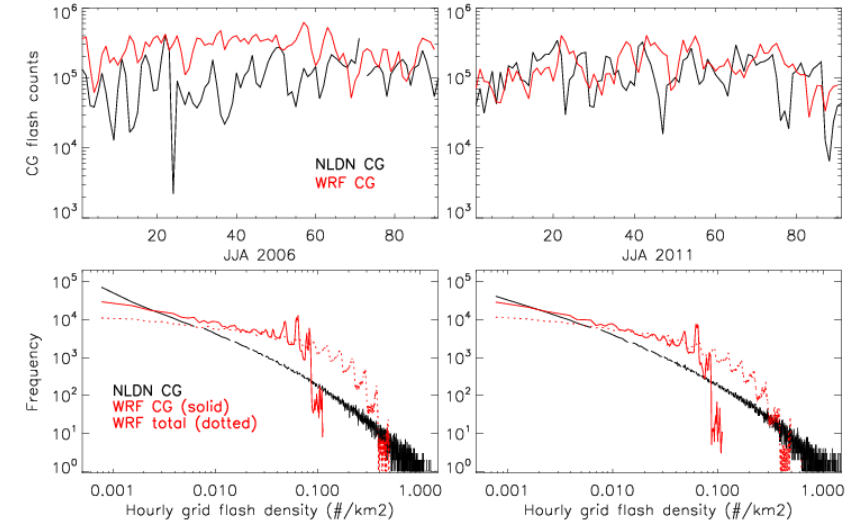
Fig. 5. Comparisons of time series and frequency distributions between NLDN CG flash counts (black) and WRF predicted CG flash counts (red) at 36km within the analysis domain defined in Fig. 1. Total flash counts predicted by WRF are shown as dotted red lines. in the modeled precipitation, which is used as a proxy for in Arizona simulated by WRF for 2011 is coincident with a quantifying the comparison of simulated convective strength severe low bias in the same region for the CG flash density. against observations. Similarly, both flash rate and precip- Otherwise, flash densities are within the order of magnitude itation are over-predicted in the Colorado and New Mexico of those observed for regions where simulated precipitation region for 2006. On the other hand, the low precipitation bias is consistent with NWS